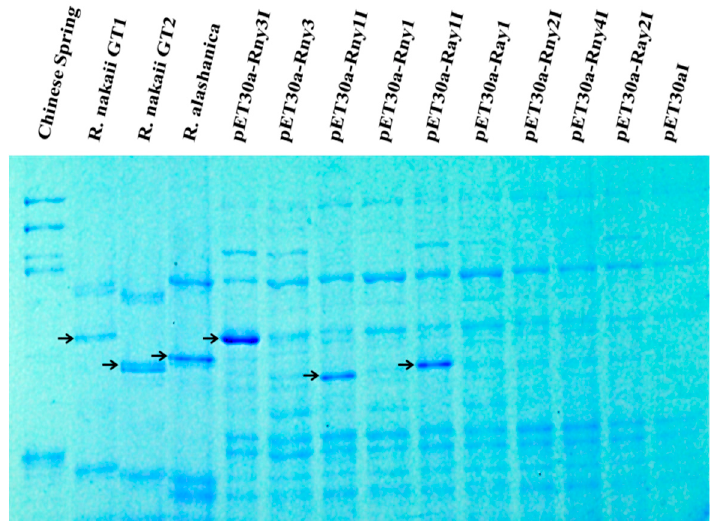
Figure 5. Heterologous expression of the HMW-GS genes from R. nakaii and R . alashanica in E. coli . The electrophoresis patterns showed the three isopropyl β - D -1-thiogalactopyranoside (IPTG)-induced Roegneria HMW-GSs in E. coli , Rny1, Rny3, and Ray1 had the same mobility with those of HMW-GSs extracted from Roegneria seeds. The three pseudogenes, Rny2 , Rny4 and Ray2 , did not express protein under the IPTG-induced condition. The HMW-GSs extracted from Roegneria seeds (lanes R. nakaii GT1, GT2, and R. alashanica ) and expressed in E. coli (lanes pET30a- Rny3 I, pET30a- Rny1 I, and pET30a- Ray1 I) are marked by arrows. The Chinese Spring HMW-GSs (1Dx2, 1Dy12, 1Bx7, 1By8) extracted from seeds were used as controls.